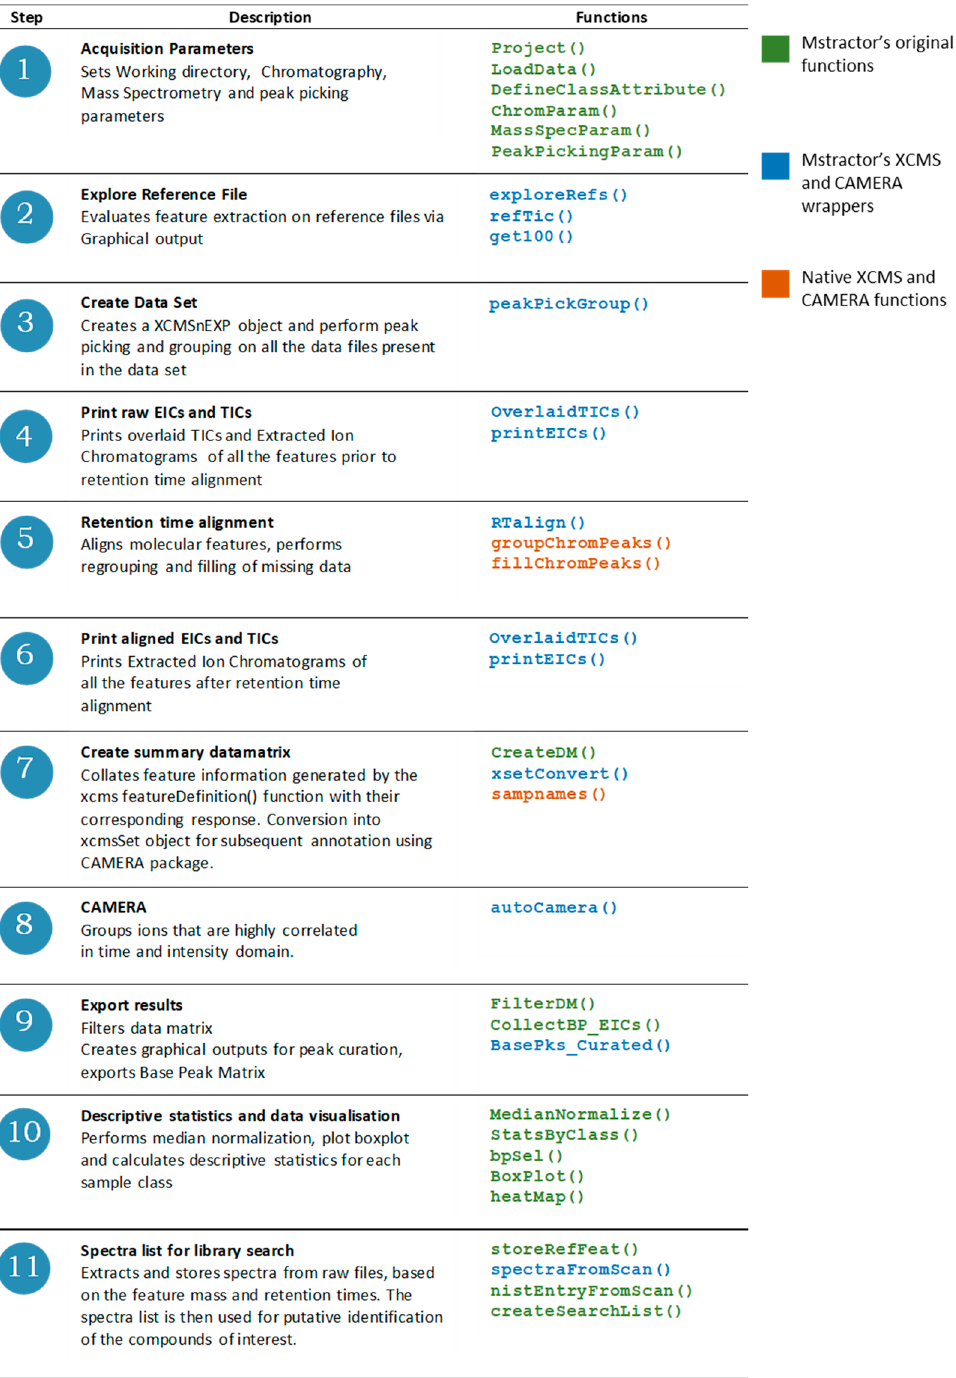
Figure 1. Schematic representation of the MStractor workflow and associated functions.